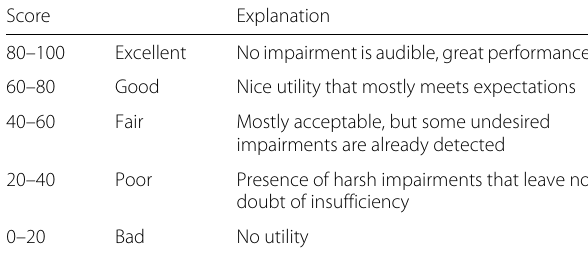
Table 1 Score specification for rating the binaural